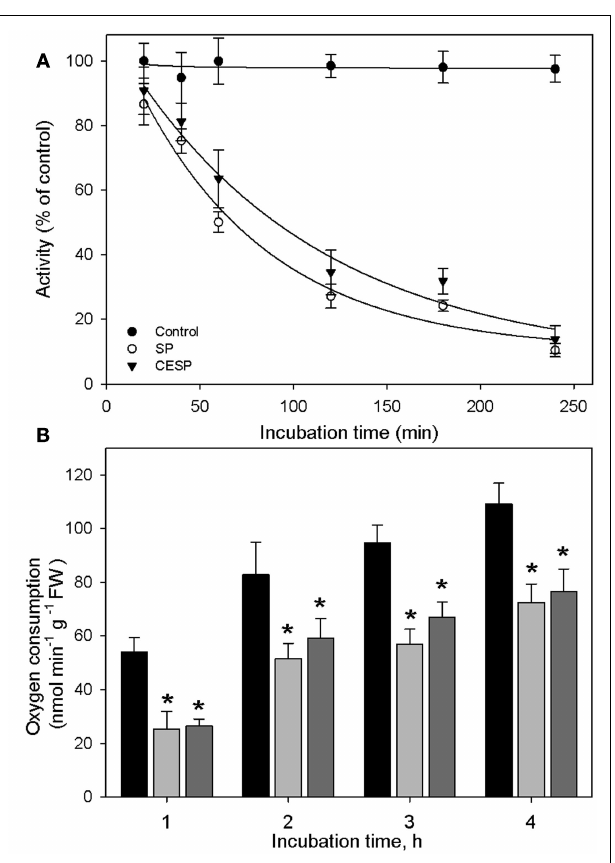
FIGURE 1 | Inhibition of the 2-oxoglutarate dehydrogenase complex activity by SP and CESP. (A) Incubation of leaf disks with phosphonate analogs inhibit the activity of the 2-OGDHC. Arabidopsis thaliana leaf disks were incubated in 10mM MES-KOH (pH 6.5) with 100 μ M SP (white circle) or CESP (black triangle) for up to 4h in similar light growth conditions.The control (black circles) was incubated in the absence of inhibitor. At the times indicated, the leaf disks were washed with 10mM MES-KOH (pH 6.5) to remove excess inhibitors and then homogenized. 2-OGDHC activity of the extracts was measured in the standard assay medium without the inhibitors. Each value is the mean ± SE of six biological replicates. (B) Respiration of leaf disks incubated in the absence (black bars) or presence of 100 μ M SP (gray bars) or CESP (dark gray bars). Freshly prepared leaf disks were transferred into the temperature controlled measuring chamber of an oxygen electrode containing 1mL of 10mM MES-KOH, pH 6.5. Each determination was performed in six biological replicates, and data presented are means ± SE of these replicates.The asterisks demarcate values that were judged to be significantly different from the control ( P < 0.05) following the performance of Student’s t -tests. FW, fresh